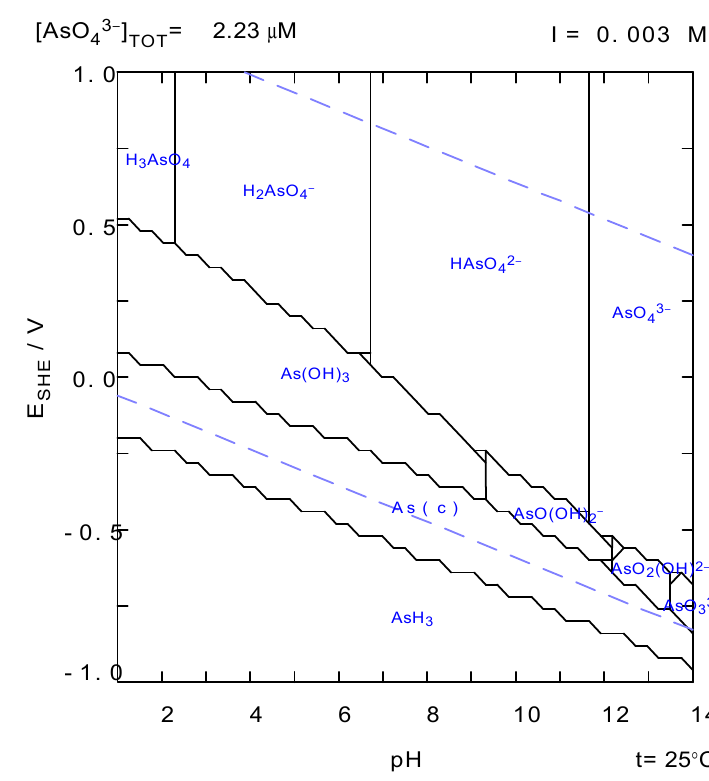
Figure 3. Eh-pH diagram for predominant arsenic species in equilibrium in raw water from Well No. 2 (Initial 0.167 mg As·L − 1 ; pH 7.14, Eh 0.23 V) at 25 °C and 1